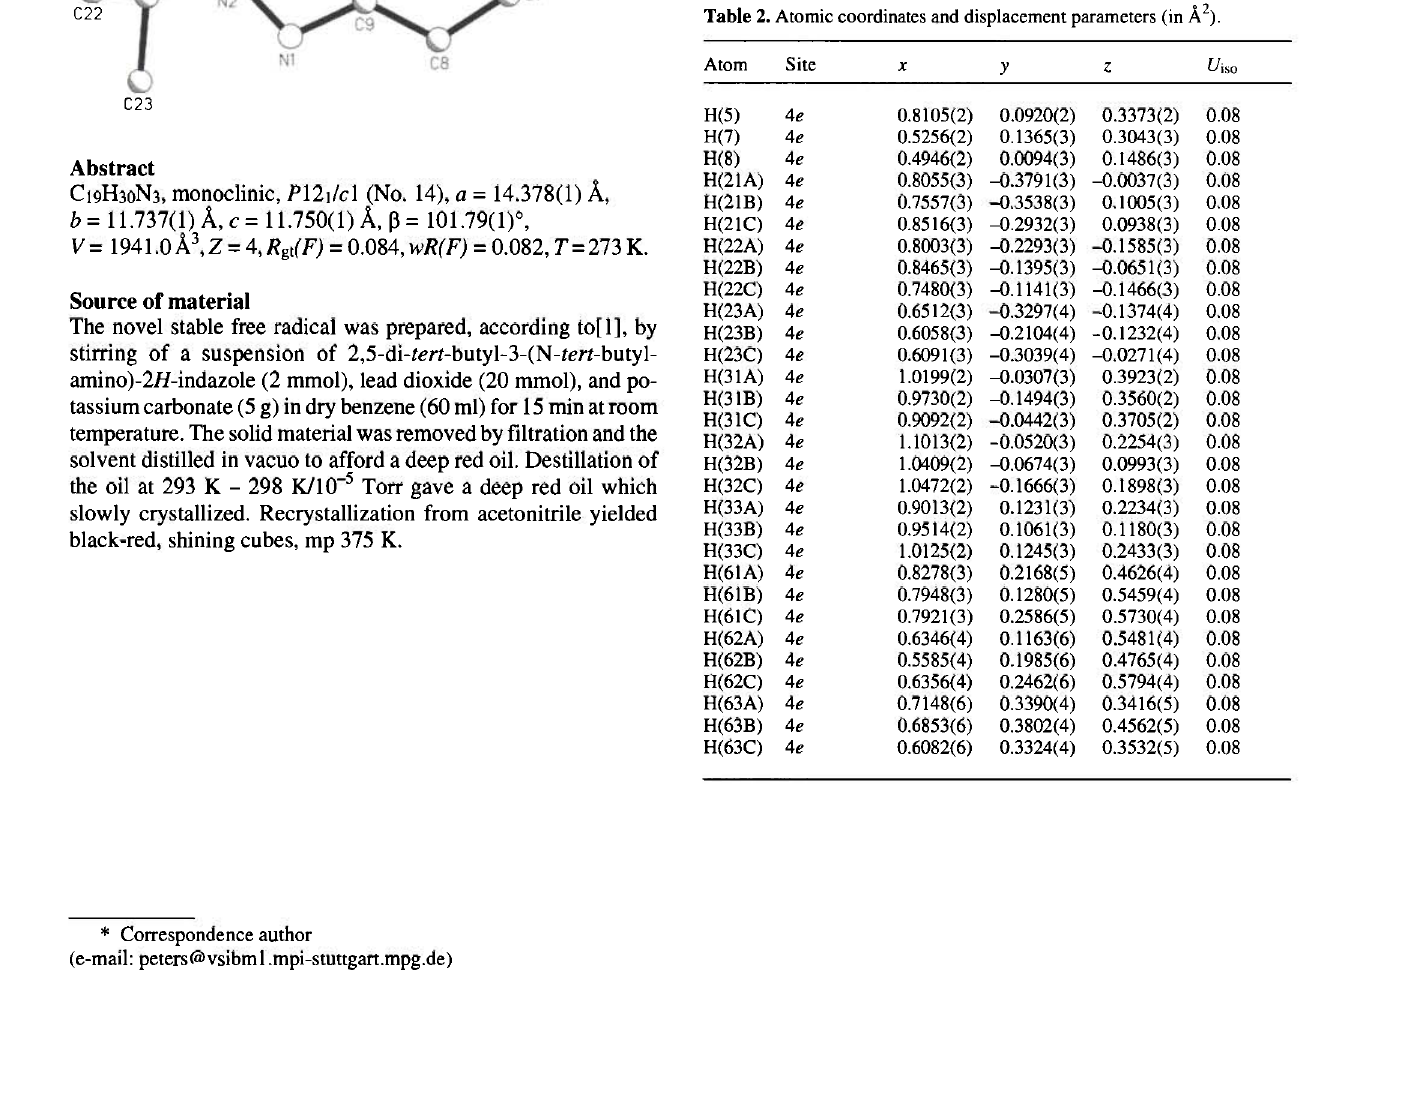
Table 1. Data collection and handling.